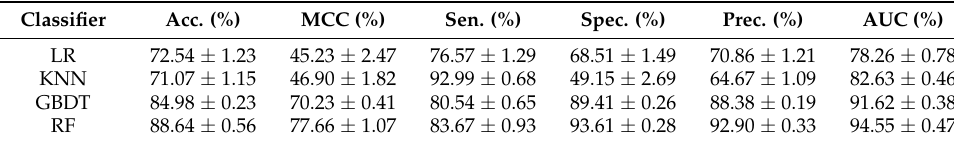
Table 2. Comparison of different machine learning classifier.